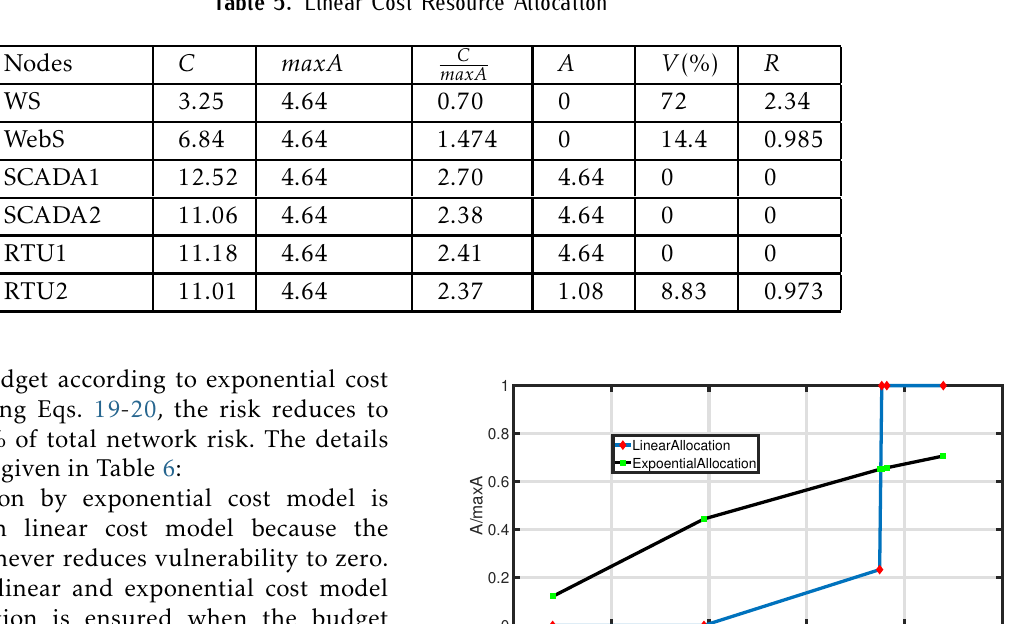
Table 5. Linear Cost Resource Allocation